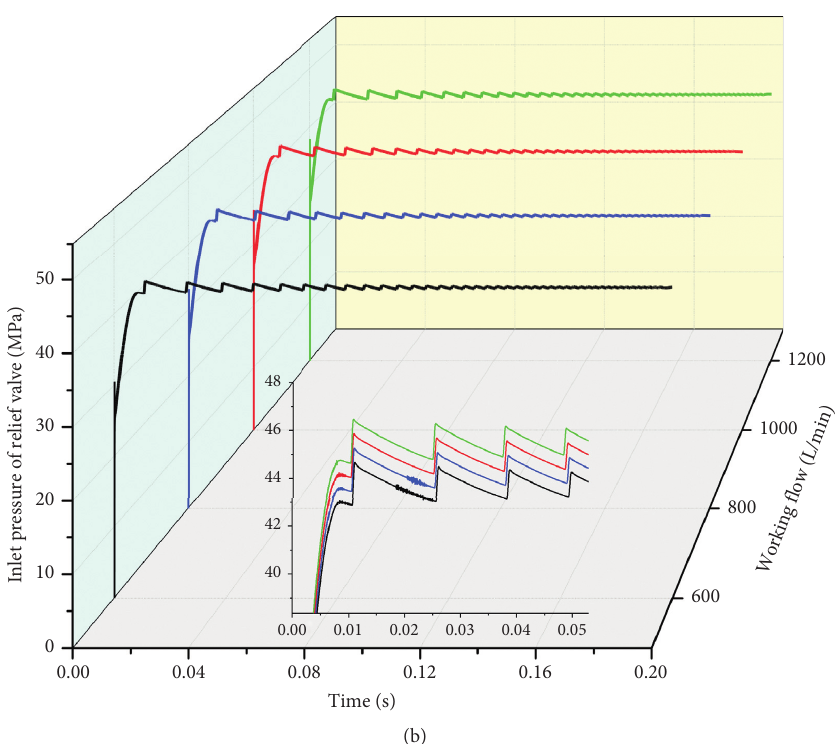
Figure 28: Pressure curves of digital relief valve. (a) Under different working pressure. (b) Under different working flow.